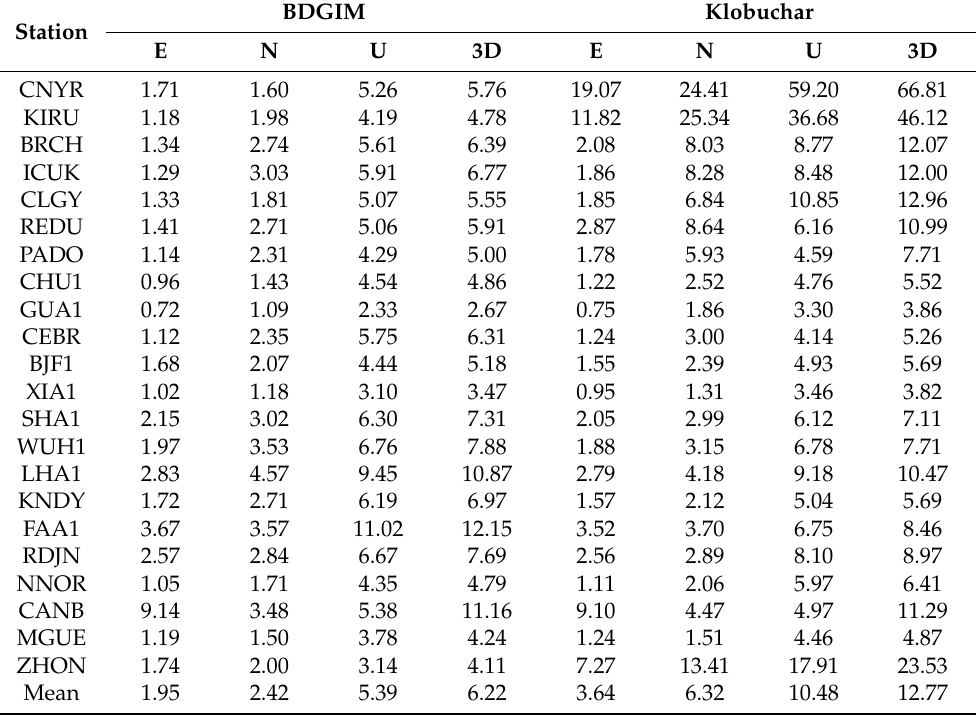
Table 8. The average accuracies of each station during the geomagnetic storm (unit: m). BDGIM Klobuchar Station E